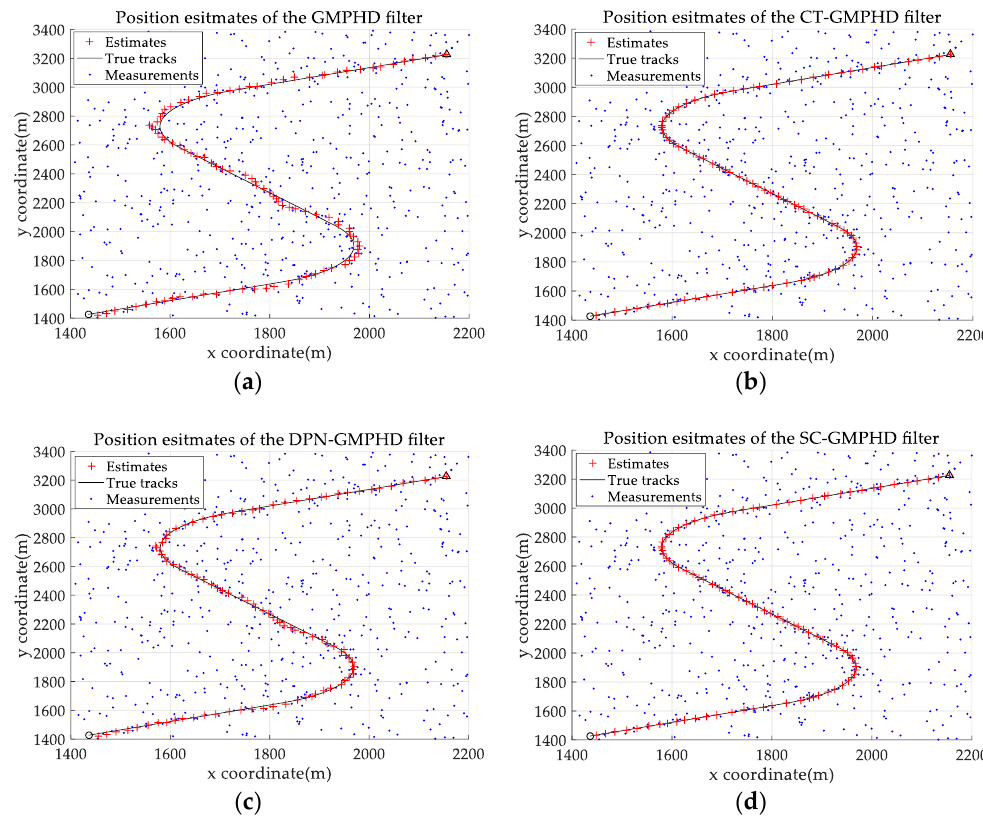
Figure 9. Filtering performance comparison of four filters for a target on a curved road: ( a ) standard GMPHD filter; ( b ) CT-GMPHD filter; ( c ) DPN-GMPHD filter; ( d ) SC-GMPHD filter.